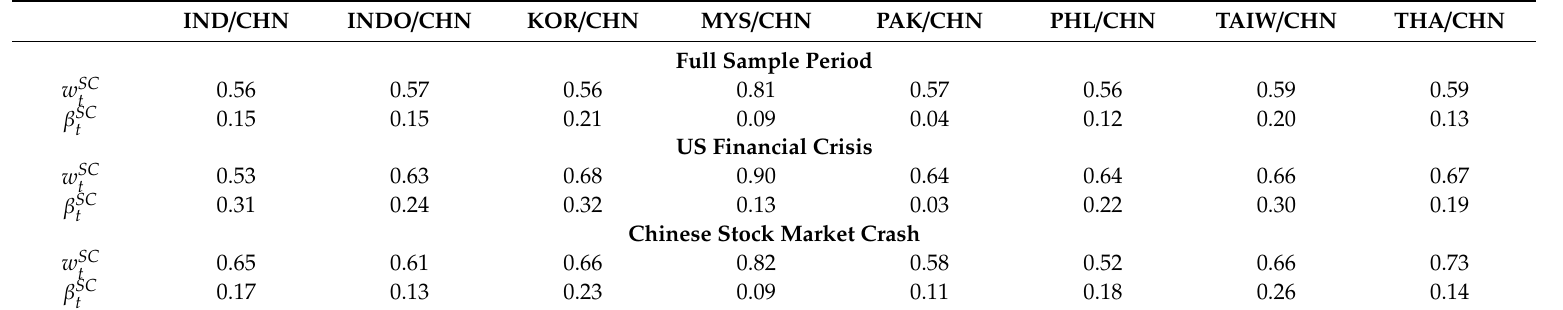
Table 9. Optimal Weights and Hedge Ratios for Asia / China